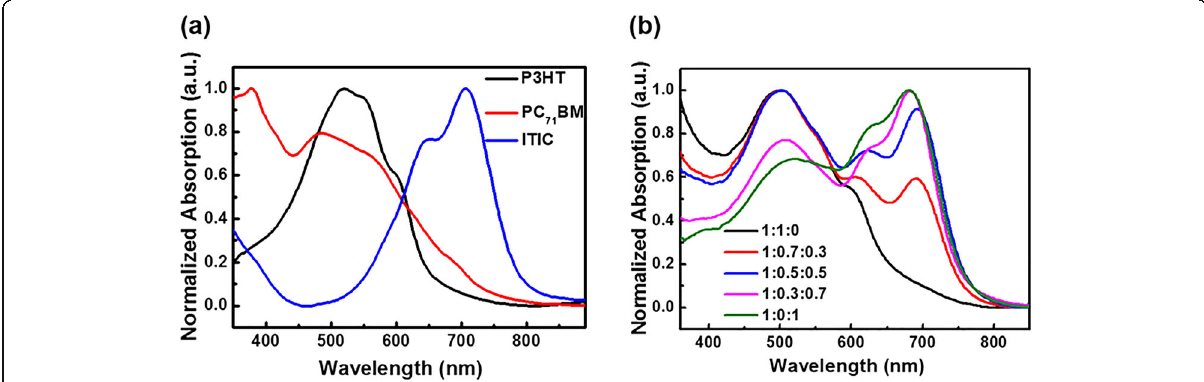
Fig. 2 a Absorption of pure P3HT, PC 71 BM, and ITIC films. b Absorption spectra of active layers with different